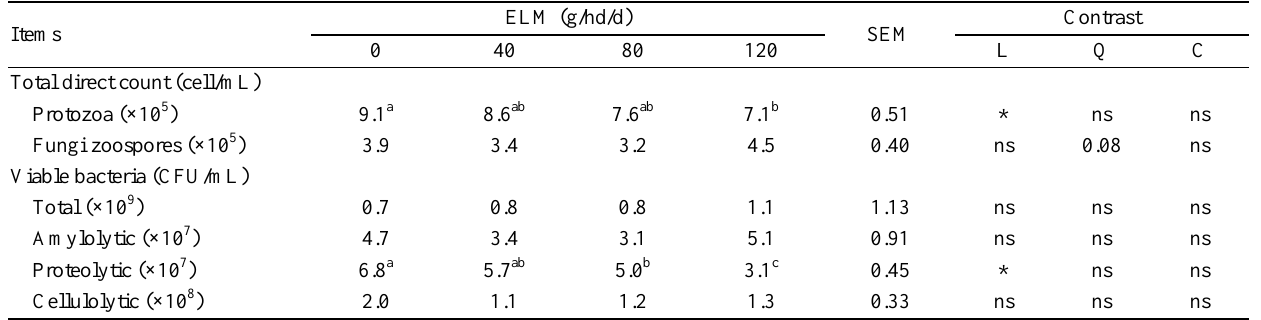
Table 4. Effects of Eucalyptus leaf meal supplementation on rumen microbial population Items